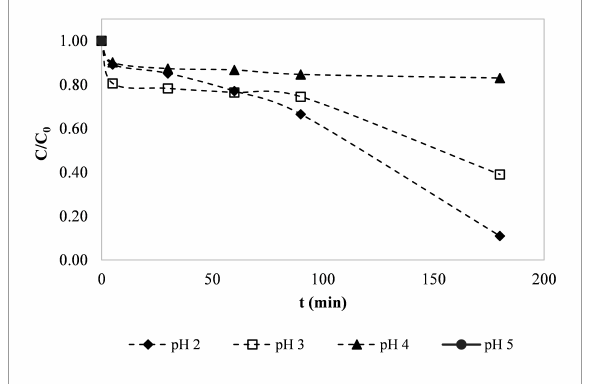
Fig. 7. Effect of Temperature